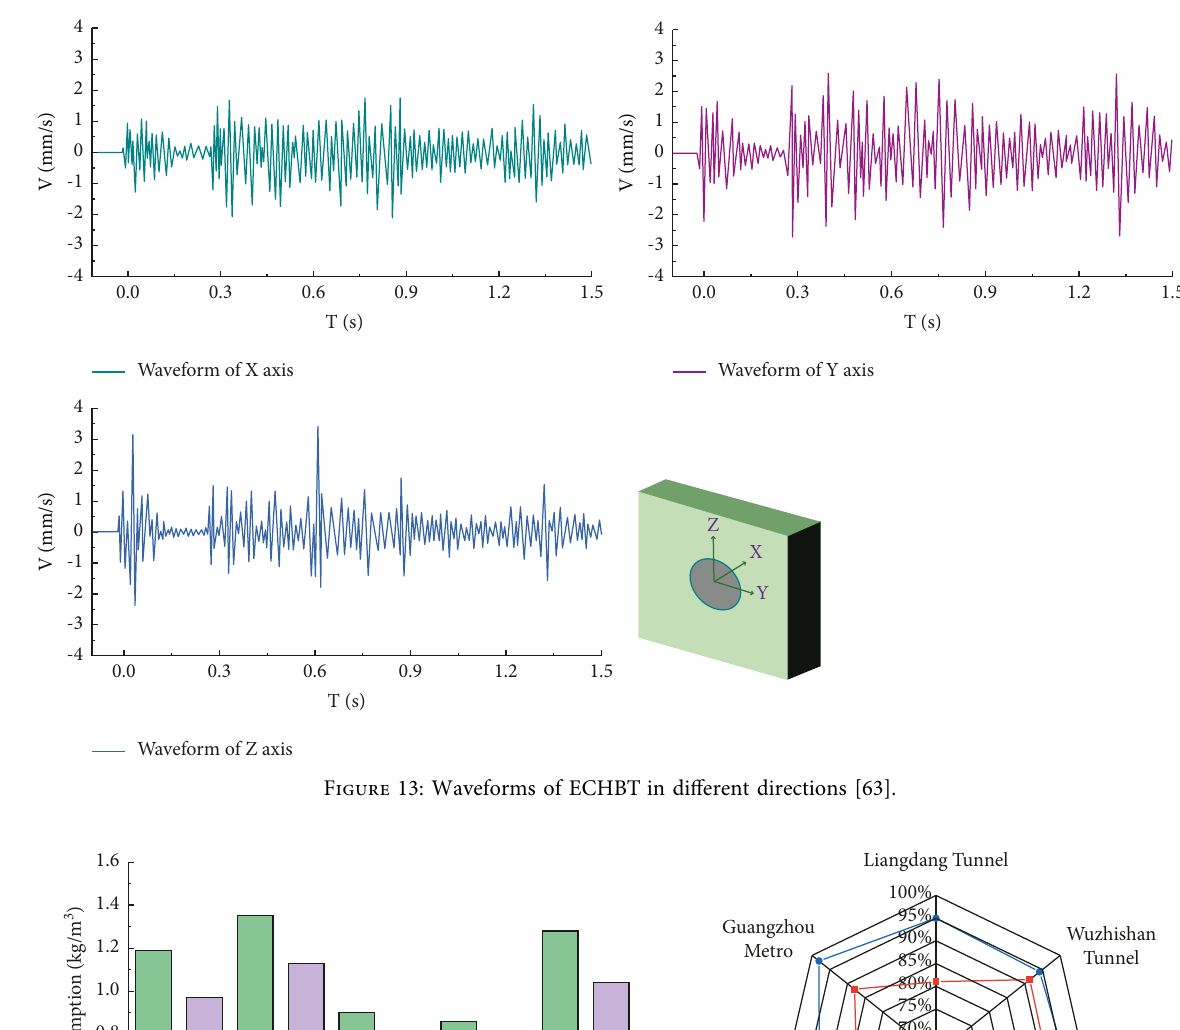
Figure 13: Waveforms of ECHBT in different directions